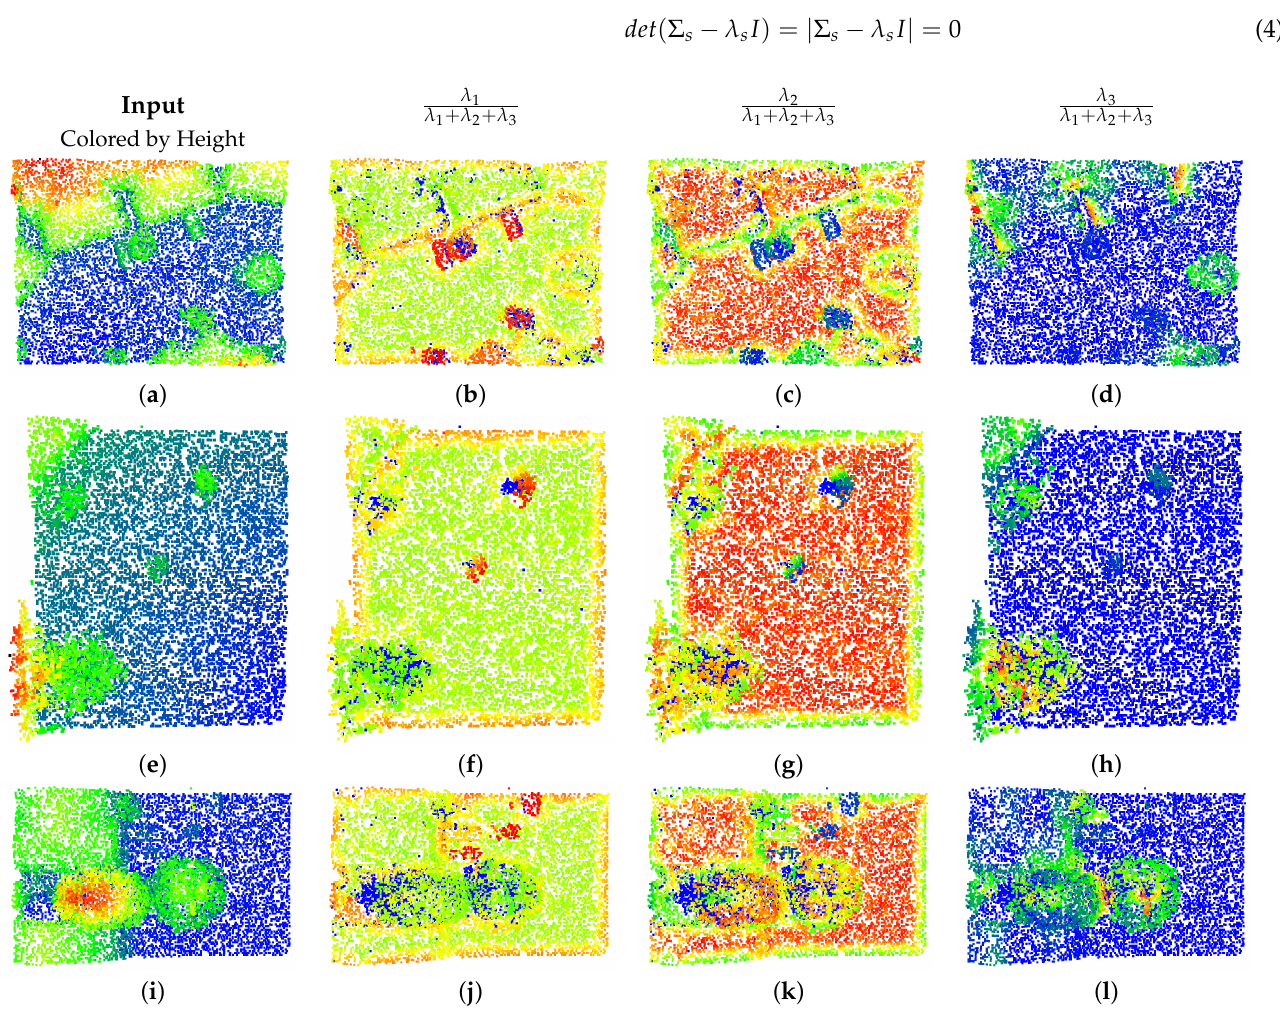
Figure 4. Visual example local eigenvalues representing different spatial properties on the DALES Viewpoints Version 2 dataset. The original input point cloud is colored by height. The Eigen feature representations are colored by value, with warm tones indicating high values and cool tones indicating low